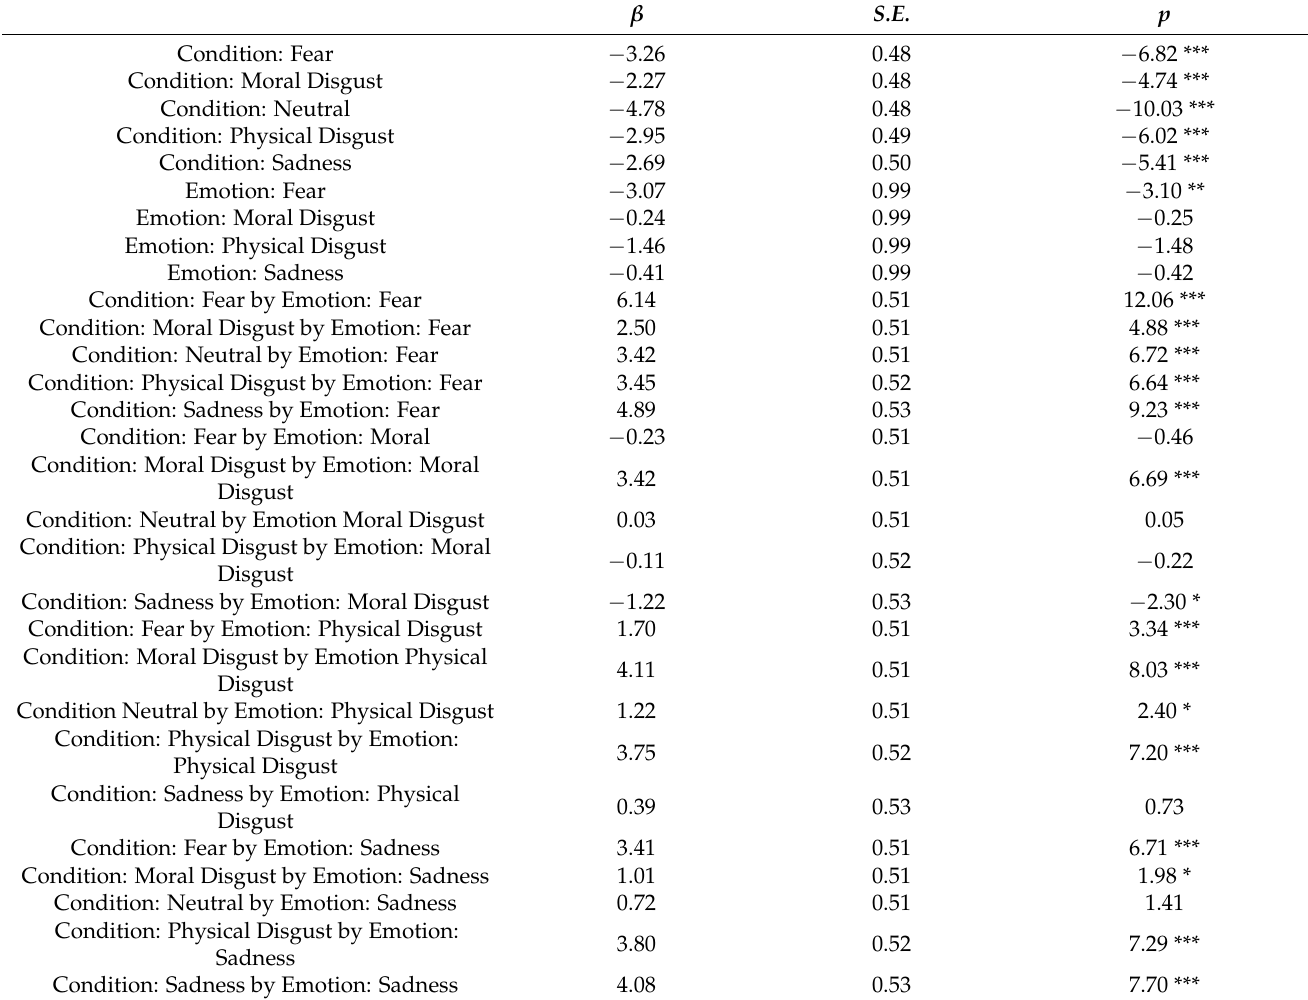
Table 2. Results of the LMM, conducted in Experiment 1. Analyses conducted on the individual ratings using the fixed effects of the condition (Ager, Moral disgust, Physical Disgust, Neutral), the emotion (Anger, Sadness, Fear, Moral disgust, Physical Disgust), and their interaction